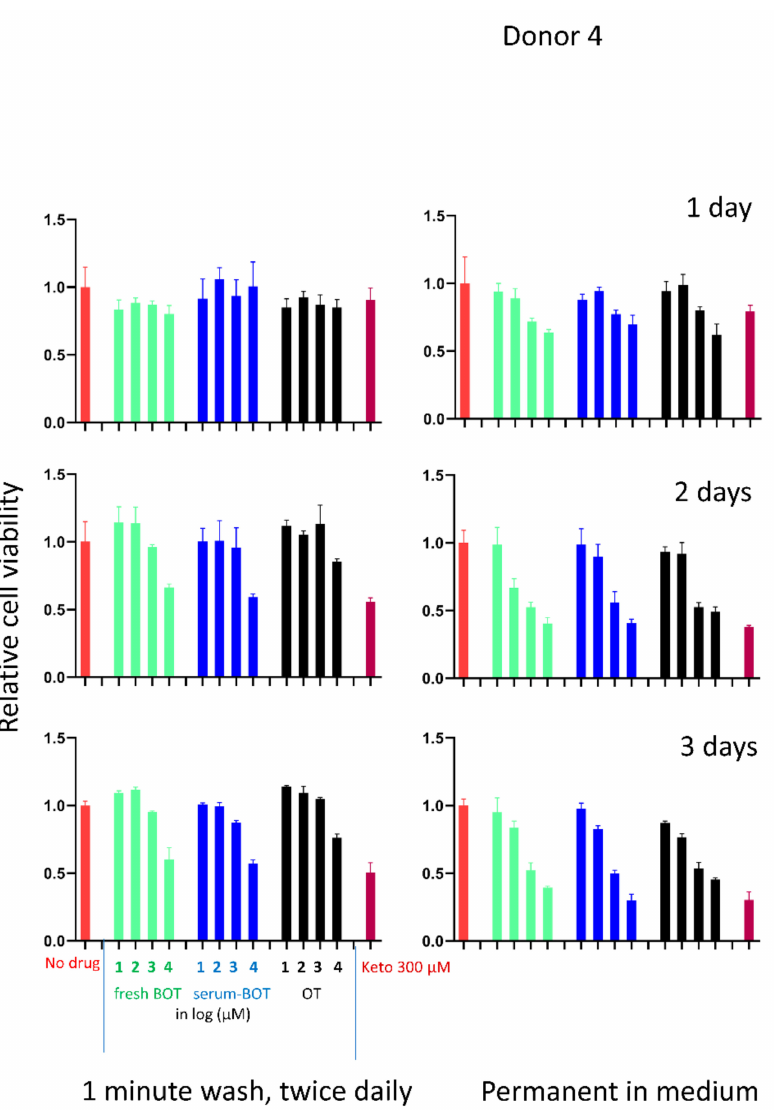
Figure 3. Conventional treatment with B-OT in the medium over the treatment period of 3 days. The gingival cells were derived from a 4th donor tooth. The flushing treatment was also carried out 2 days in both the flushing and conventional